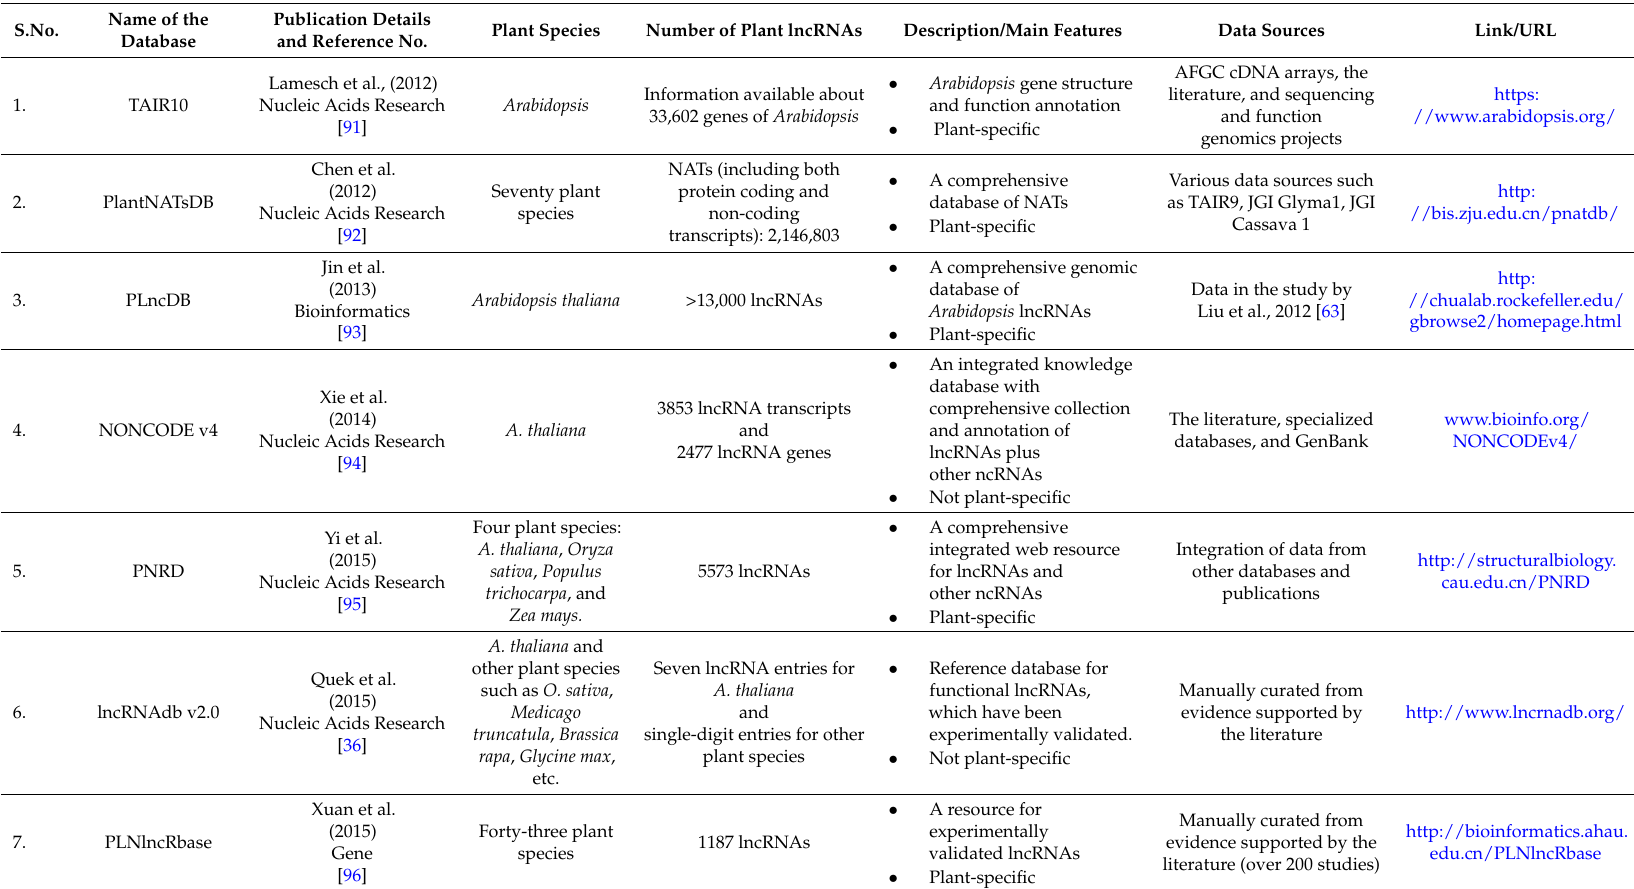
Table 2. An overview of the currently available databases for plant